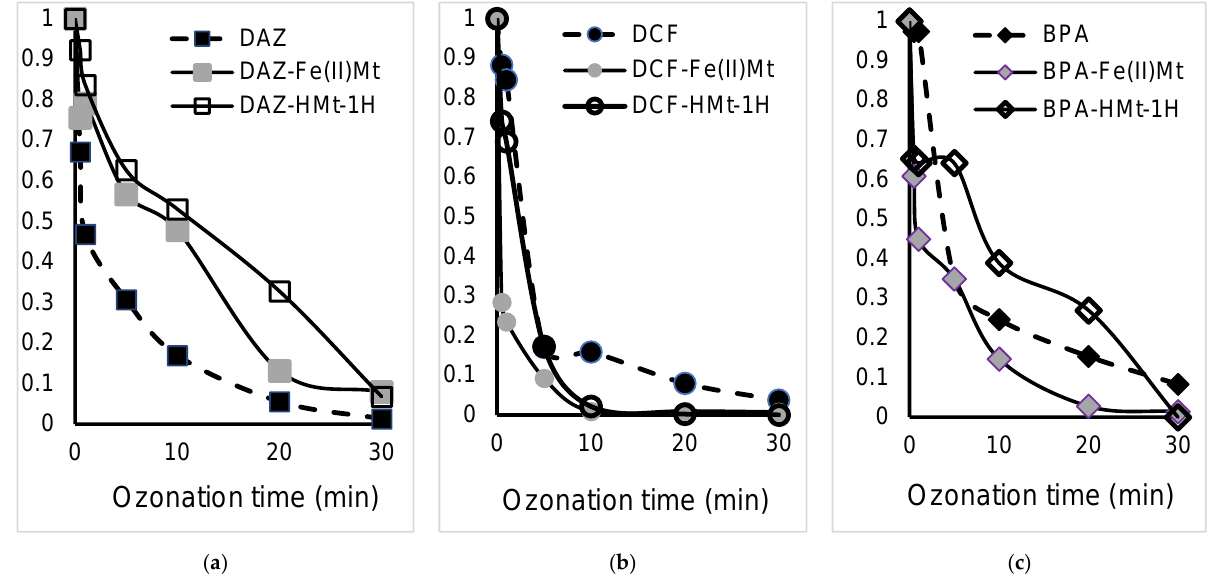
Figure 5. Comparative evolution of the HPLC-UV peak area ratio (P A /P Ao ) of the aqueous solutions of DAZ ( a ), DCF ( b ) and BPA ( c ) during ozonation at room temperature in the absence and presence of both clay catalysts. V = 30 mL, Ozone throughput = 600 mg h −1 ; Initial concentration of organic substrate = 30 mg L −1 ; Catalyst amount: 40 mg.